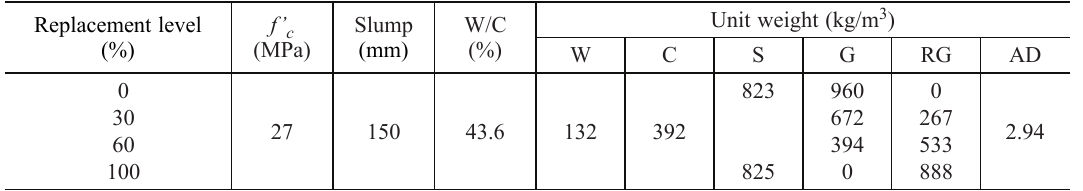
Table 3. Mix design for